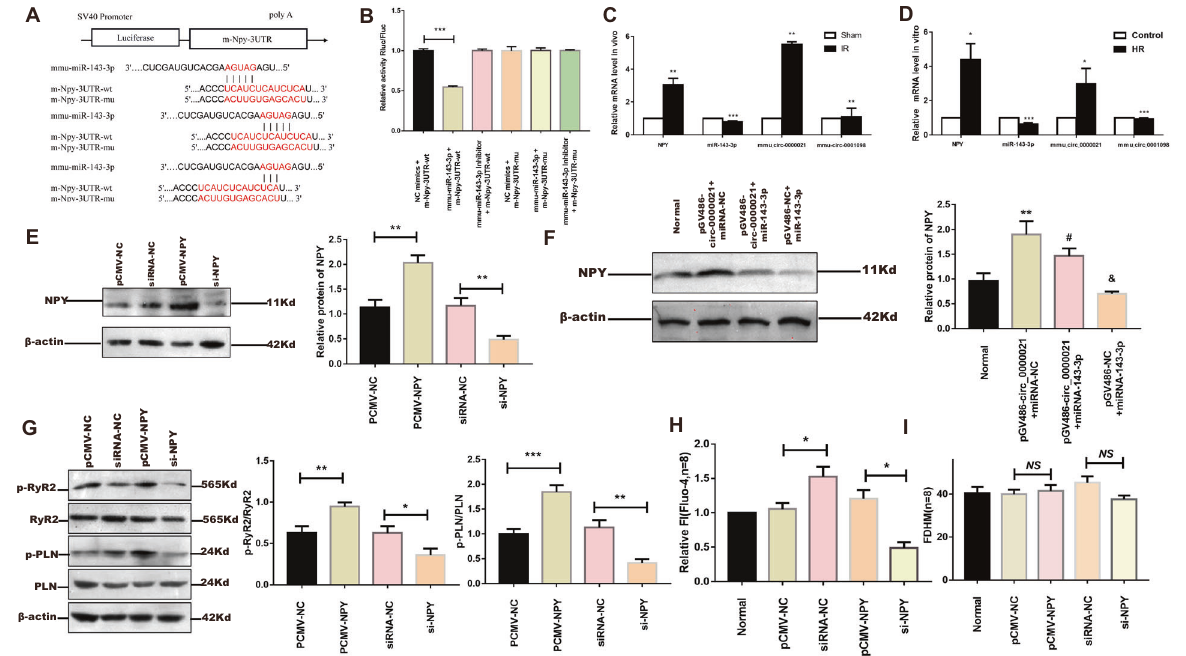
Fig. 3 NPY is the target of mmu_circ_0000021 in NMCMs. A Target binding of miR-143-3p and NPY. B Dual-luciferase reporter assay for miR- 143-3p and NPY. C , D In vivo and in vitro experimental veri fi cation of mmu_circ_0000021, expression of miR-143-3p and NPY. E Gene and protein expression of NPY after plasmid transfection. F Western blot showing that the increase of NPY caused by mmu_circ_0000021 was attenuated by miR-143-3p. G Overexpression of NPY increased the level of p-RyR2 and p-PLN and vice versa. H Overexpression of NPY increased the fl uo-4am value in NMCMs. * P < 0.05; n = 8/group. I Bar graph showing that changes in NPY in NMCMs had little effect on Ca 2 + transients. * P < 0.05, *** P < 0.001 vs. indicated group; NS not signi fi cant, n =